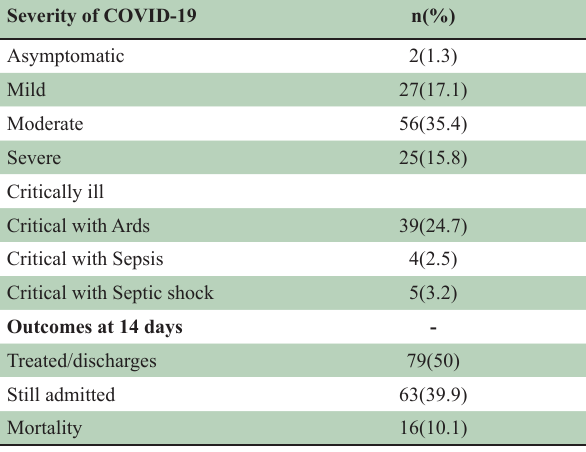
. Table-I: Frequency distribution of severity of COVD-19 and outcome at 14 days of